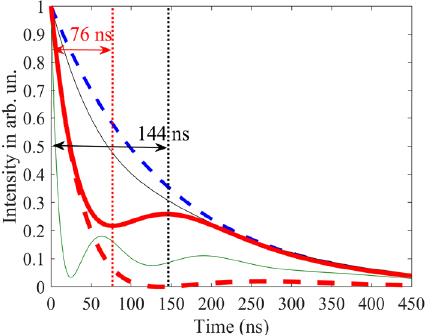
Figure 7. Waveforms of the of 14.4-keV Lorentzian single-photon wave packet. The blue dashed line 0.56 MHz . Other lines ( 2 π) corresponds to the incident photon waveform emitted by 57 Co RMS with γ S = γ S . The red dashed line corresponds to the are the waveforms at the exit from the 57 Fe absorber with γ 21 = (cid:31) 6 in comparison with the red solid line for the same absorber vibrating at the motionless absorber with T a = 3 with amplitude R 1 ( p 1 2.4 , see Eqs. (13), (14)). The red solid line has the Sommerfeld- γ 21 frequency � = = 1 24 ns at half-height, transmitted without delay, and ( 2 γ 21 T a ) Brillouin precursor with duration τ SB ≈ ≈ (cid:31) the delayed part of the single-photon wave packet. The green line demonstrates the dynamical beats in the (cid:31) 30 , where the concept of the waveform of the photon passed through the same vibrating absorber with T a = propagation delay and velocity becomes inapplicable. The black solid thin line is plotted for the same vibrating 1 . All curves are plotted using numerical integration of Eq. (33). absorber with T a =